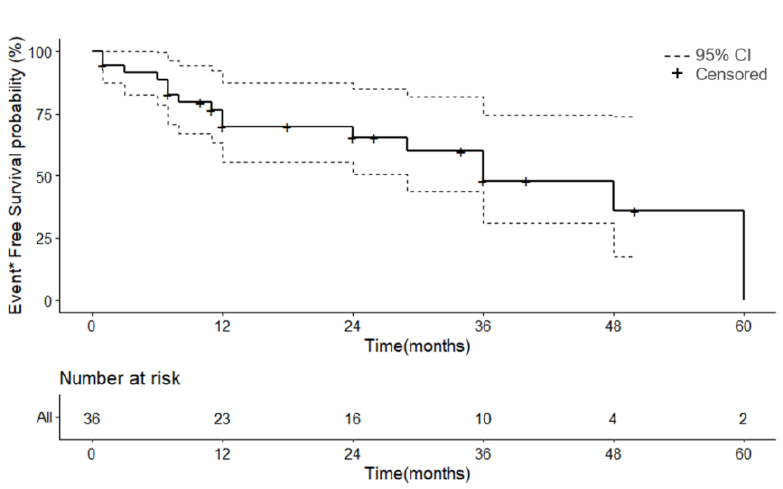
Figure 3. Event-free survival probability of patients with eyelid angiosarcoma. CI = confidence interval, * Event includes recurrence and death.